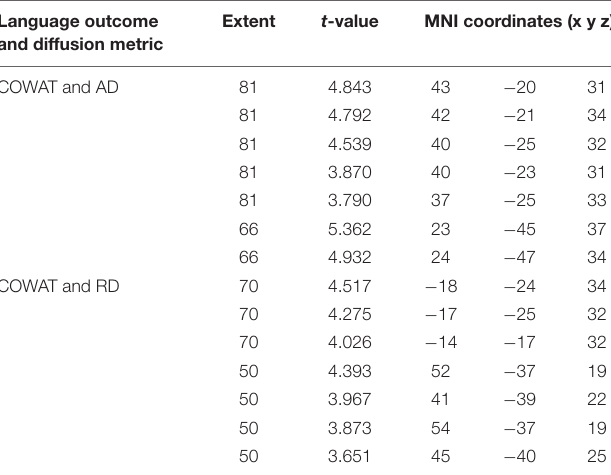
inferior–superior dimensions, respectively. TABLE 4 | Locations of regions showing significant positive relationships between COWAT performance and AD (shown in Figure 4A ) and RD (shown in Figure 4B